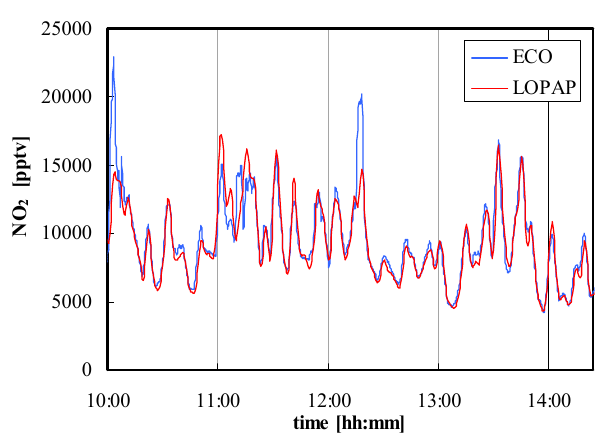
Fig. 9. Selected time interval of the NO 2 concentrations measured Fig. 9 Selected time interval of the NO 2 concentrations measured with the NO 2 -LOPAP with the NO 2 -LOPAP and the Eco-Physics instruments during the and the Eco-Physics instruments during the ambient intercomparison campaign at ambient intercomparison campaign at the University of the University of Wuppertal.